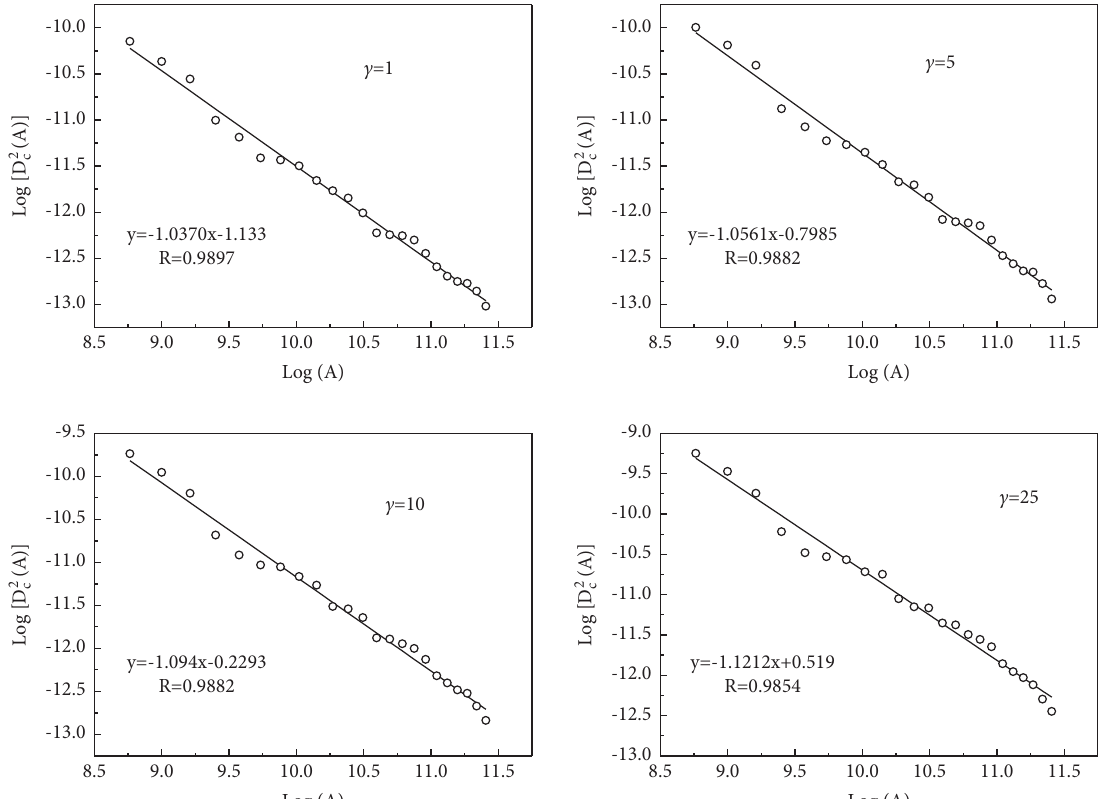
Figure 9: Parameter ftting results for diferent c values ( k � 0 . 08).